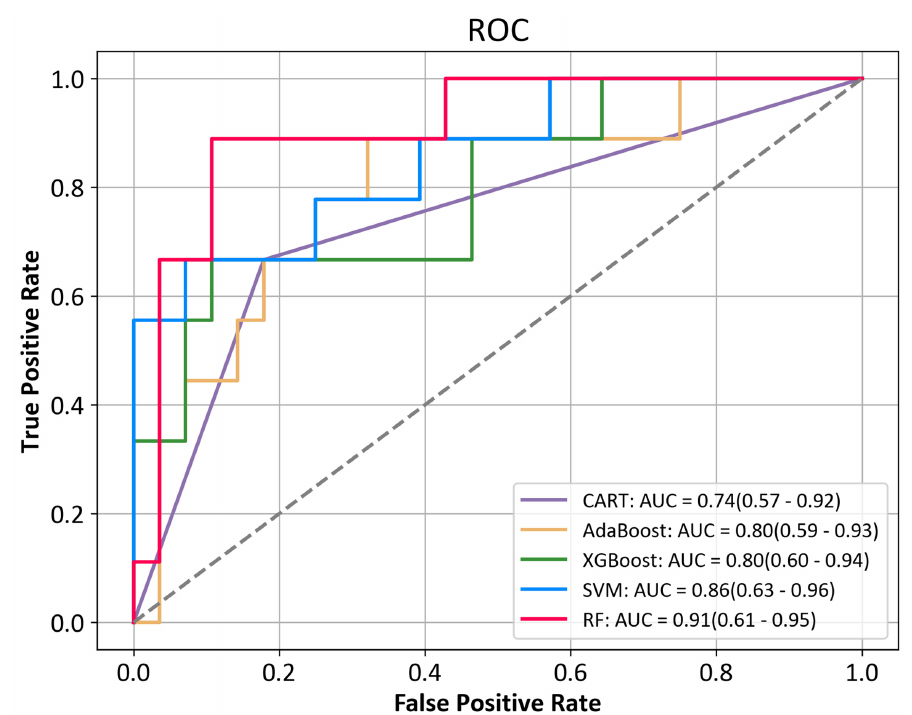
Figure 2. ROC curves for differentiating nonresponse and response using the machine learning algorithms. ROC, receiver operating characteristic; CART, classification and regression tree; AdaBoost, adaptive boosting; XGBoost, extreme gradient boosting; SVM, support vector machine; RF, random forest. The RF algorithm revealed the largest AUC (0.91), and the AUCs of the SVM, XGBoost, AdaBoost, and CART were 0.86, 0.80, 0.80, and 0.74, respectively. Then, we ranked the relative importance of the 40 features (Figure 3A) and identified the 10 most important predictors, including K, low-density lipoprotein (LDL), D-dimer (D-D), RBC, alanine aminotransferase (ALT), albumin (ALB), monocyte (Mono), tumor size, triglyceride (TG), and age. The box plots of the 10 predictor distributions between the nonresponse group and response group are shown in Figure 3B. The results before and after the unsu- pervised clustering of 125 patients with unresectable HCC are shown in the Supplemen- tary File S1 (Figure S2).